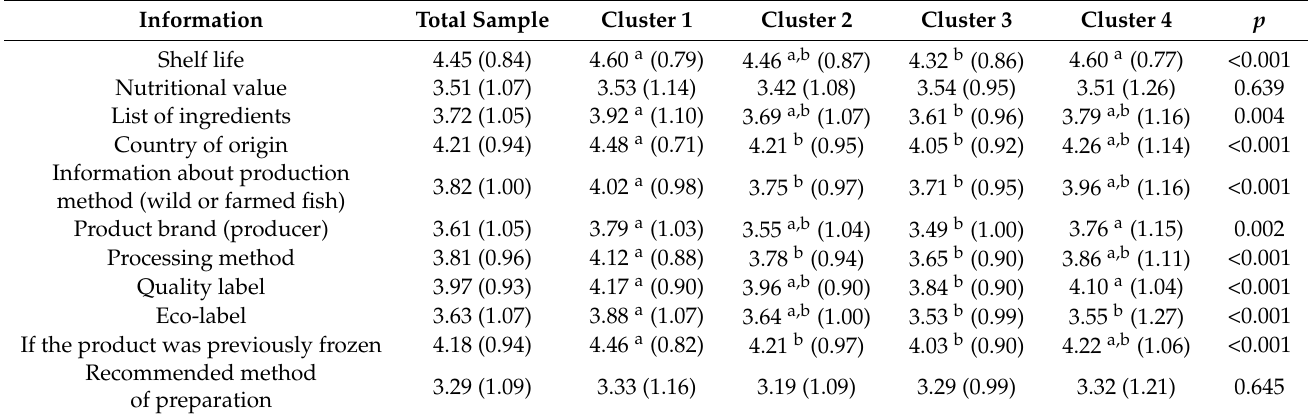
Table 4. Importance of product information for Croatian fishery consumers (n =